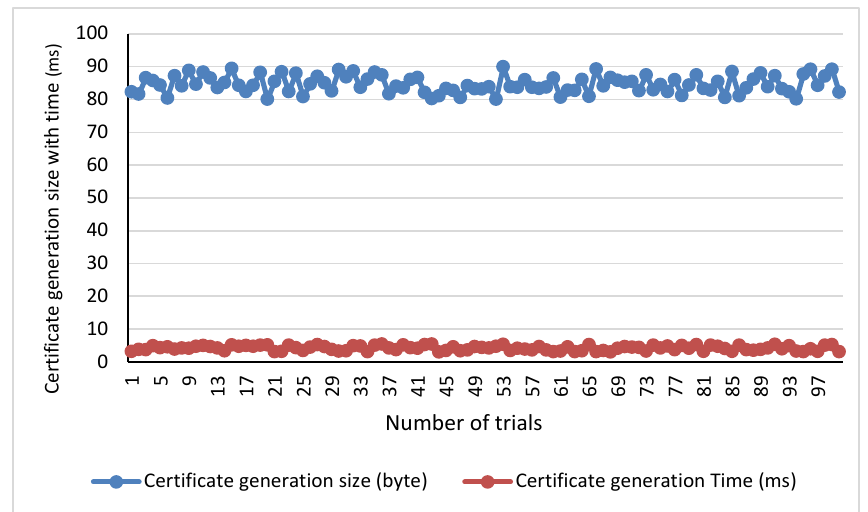
Figure 10. Certificate generation size (byte) with response time (ms) against the number of trials.